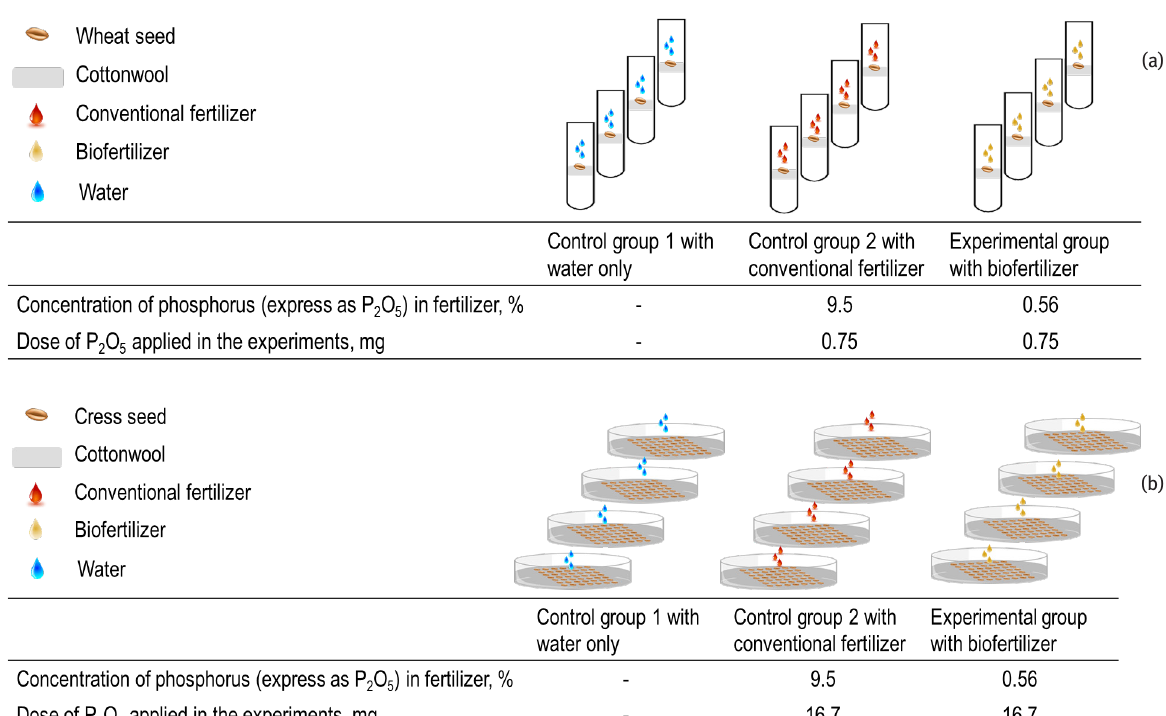
Figure 1: Diagram of the experiment: a) in hydroponic test, b) in germination